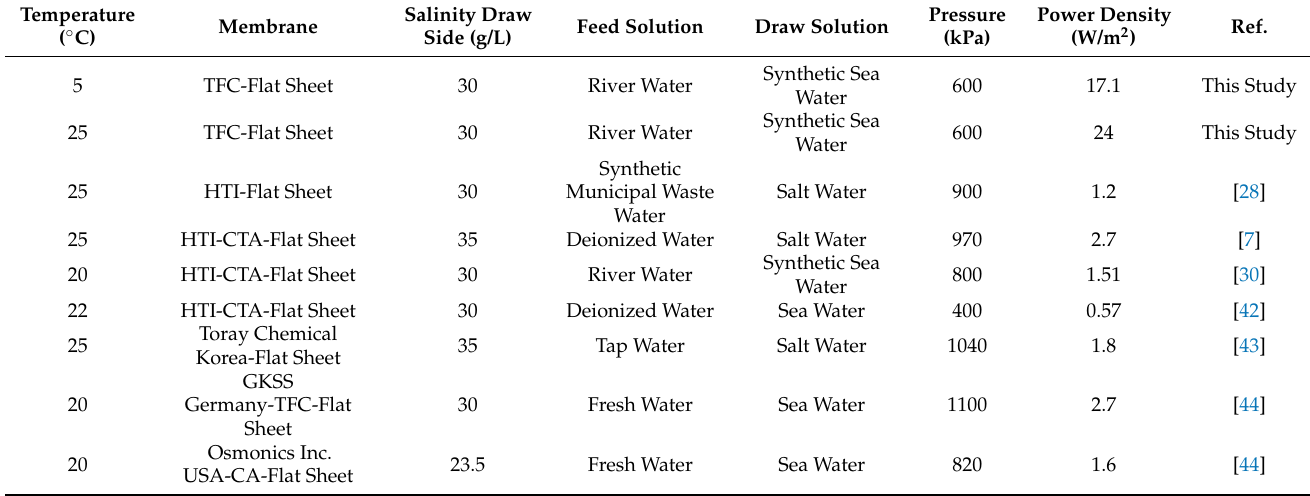
Table 2. Comparison between PRO experimental performances in this study and other reported studies in the literature using commercial flat sheet membranes.